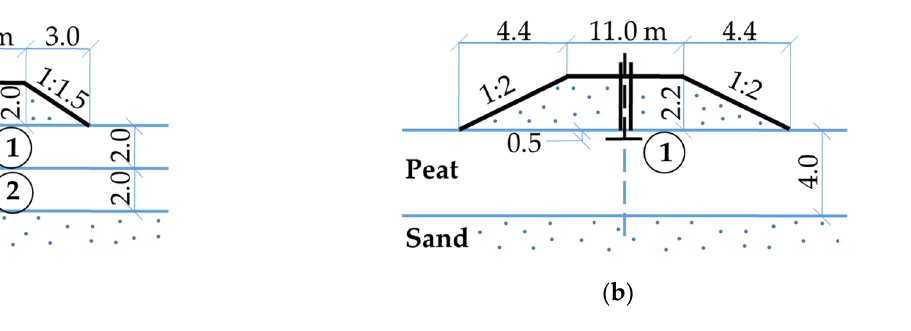
Figure 1. Test embankments at the Bia ł o ś liwie site: ( a ) embankment No. 2, ( b ) embankment No. 4, 1–surface settlement gauge, 2-deep settlement gauge.